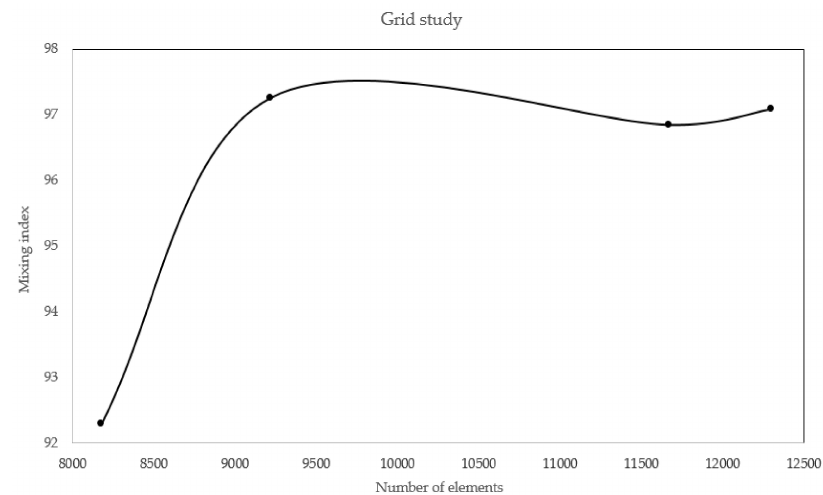
Figure 18. The accuracy of numerical solution is tightly bound to the grid. Increasing number of element increases both the accuracy and run time. The solution must be independent of element number. If the domain is discretized with more than 11,000 elements, the mixing index becomes independent of number of